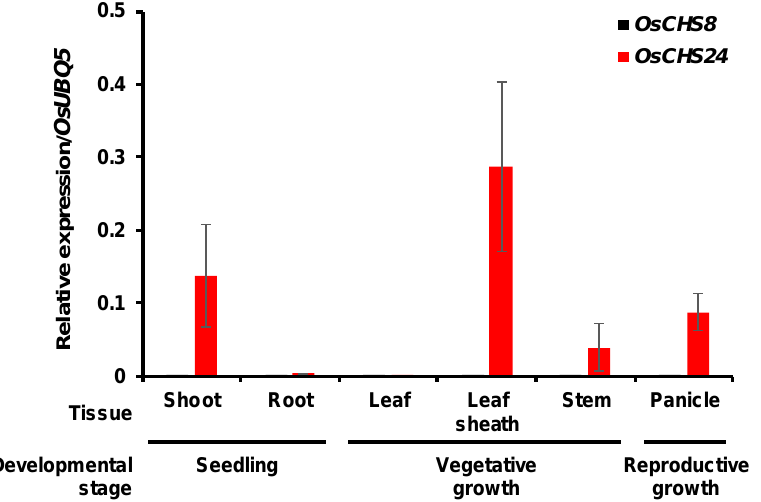
Figure 4. Quantitative real-time PCR analysis of OsCHS24 and OsCHS8 gene expression in rice seedlings and different adult tissues. Shoot and root samples were collected from seven-day-old rice seedlings. Leaf, leaf sheath, stem, and panicle samples were obtained from rice plants in vegetative and reproductive stages. An ubiquitin 5 gene ( OsUBQ5 ) was used as an internal control. Expression levels of each OsCHS gene are presented as relative expression compared to OsUBQ5 mRNA level. qRT-PCR analysis was performed on the triplicated biological samples. The results represent mean ± standard